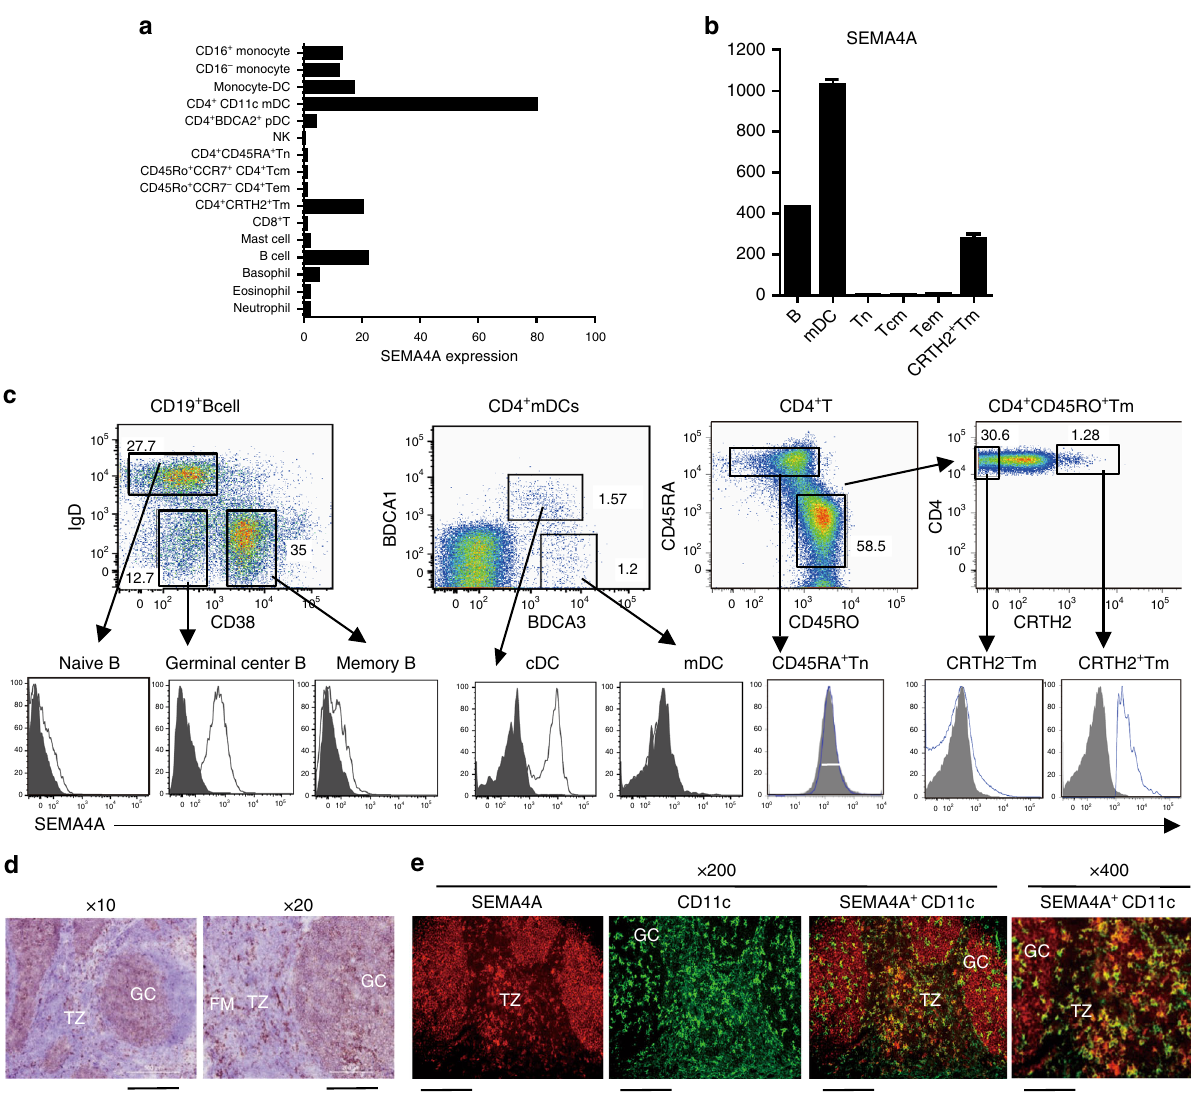
Fig. 1 SEMA4A is highly expressed in antigen-presenting cells (APCs) and CRTH2 + Th2 memory T cells. a , b Quanti fi cation of SEMA4A mRNA in different human haematopoietic cell types. The indicated human haematopoietic cell types were puri fi ed, and total RNA was isolated from each cell population for chip hybridization. Bars show the relative SEMA4A mRNA expression in each cell subset ( a ). Real-time PCR was performed to con fi rm the expression of SEMA4A mRNA in CD19 + B cells, CD4 + CD11c + myeloid dendritic cells (mDCs), as well as naive (Tn), central memory (Tcm), effector memory (Tem), and Th2 memory CD4 + T cells. The relative fold differences in SEMA4A mRNA expression between samples are indicated on the y -axis. Error bars represent the standard error of mean (s.e.m.) of different wells. Data represent one of fi ve donors in each independent experiment, which were repeated three times. b , c Flow cytometry analysis of SEMA4A expression on different populations of CD19 + B cells, CD4 + DC, and CD4 + T cells. Enriched CD4 + T cells from peripheral blood are sorted into CD45RA + naive, CRTH2 + memory Th2, and CRTH2 − memory CD4 + T cells. CD4 + conventional dendritic cells (cDCs) are gated as Lin − CD4 + BDCA1 + cells in CD4 + enriched tonsil cell; B cells are gated as CD19 + tonsil cells. The numbers in the dot plots indicate the percentage of cells in that gate. Open histograms represent the staining of indicated cell subsets with anti-SEMA4A mAb; fi lled histograms represent the isotype. Data represent one of three independent experiments. d , e Histological analysis of SEMA4A expression in human tonsil. Tonsil tissue sections were stained with anti-SEMA4A mAb followed by Horseradish Peroxidase (HRP)-conjugated goat anti-mouse antibody. Magni fi cations used for pictures are ×10 (left) with scale bar representing 500 μ m and ×20 (right) with scale bar representing 200 μ m ( b ); or double immuno fl uorescence stained with anti-SEMA4A mAb (red) and anti-CD11c mAb (green). Magni fi cations used for pictures are ×200 (left) with scale bar representing 20 μ m and ×400 (right) with scale bar representing 10 μ m ( e ). Germinal center (GC), follicular mantle zone (FM), and interfollicular T-cell zone (TZ) were indicated. Data represent one of four independent experiments